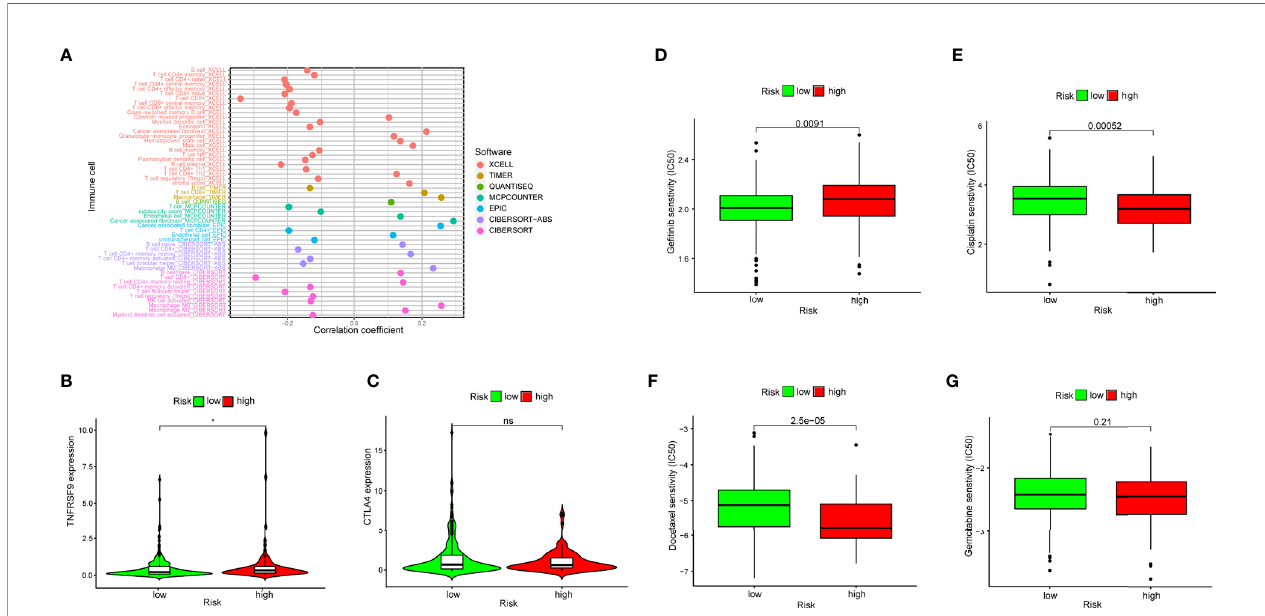
FIGURE 6 | (A) Spearman correlation analysis showed patients in the high-risk group were more positively associated with tumor-in fi ltrating immune cells, such as fi broblasts, endothelial cells, monocytes, macrophages and neutrophils. (B, C) High risk scores were positively associated with upregulated TNFRSF9 expression level, whereas CTLA4 level had no difference in high- and low-risk groups. (D – G) The model could be a predictor for chemosensitivity as higher risk scores had different IC 50 for chemotherapeutics such as ge fi tinib, cisplatin, docetaxel and